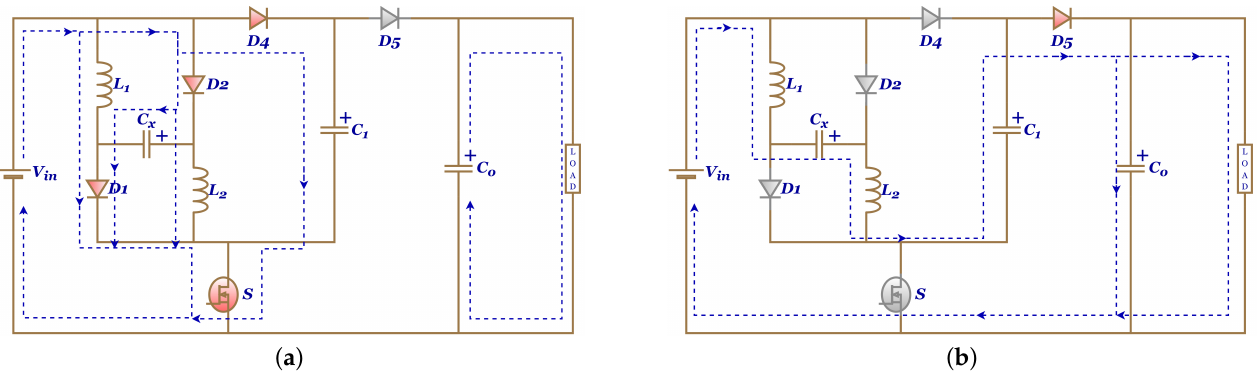
Figure 18. 2nd M-PSOL operation: ( a ) S closed, and ( b ) S open.